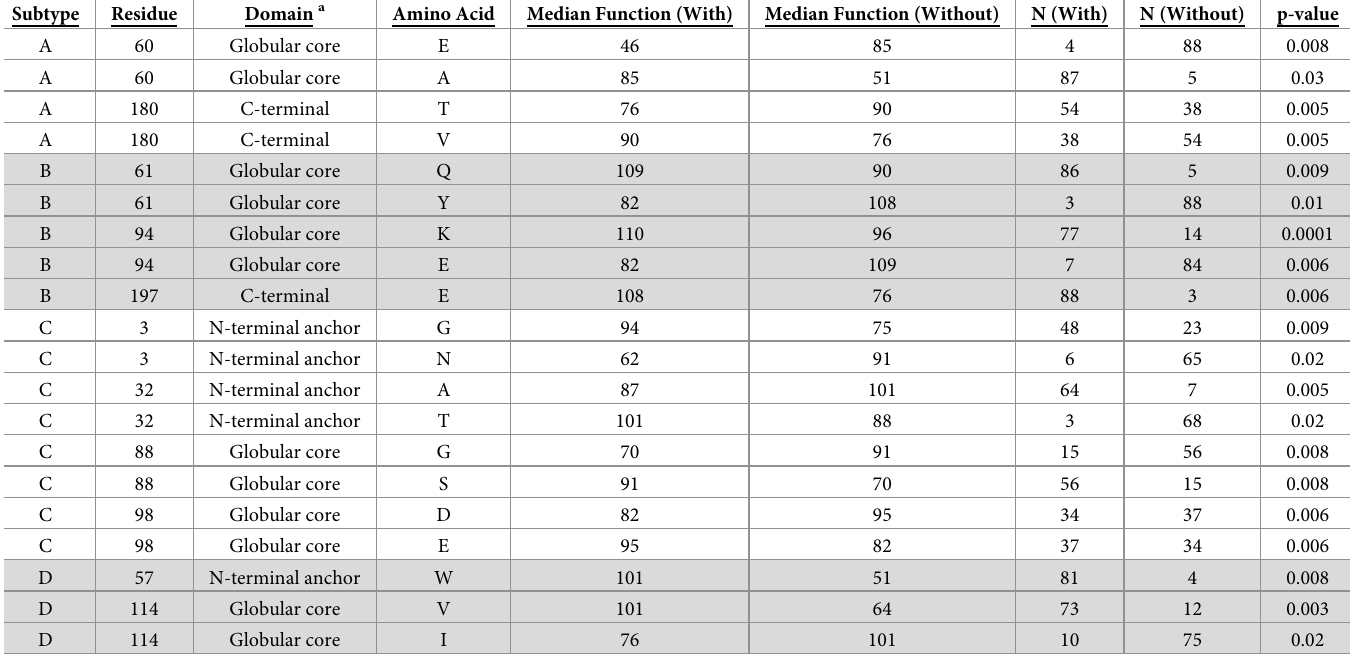
Table 1. Selected Nef polymorphisms associated with SERINC5 internalization